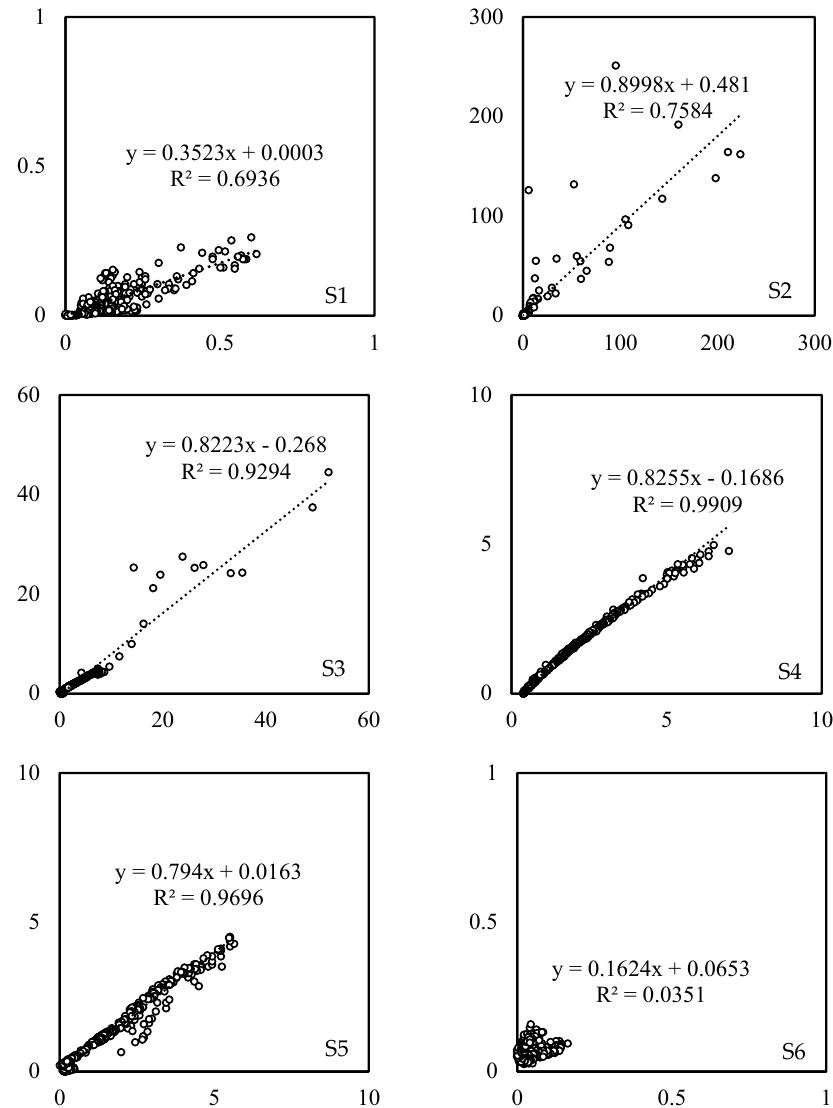
Figure 5. Correlations between R134a concentrations at six sampling points measured by the two novel system receivers. S1 to S6 are the sampling locations.